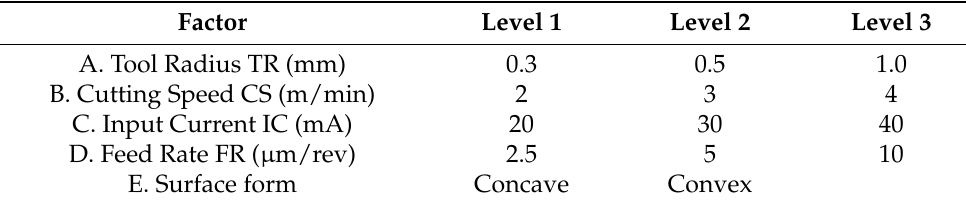
Table 1. The experimental factors and their levels.